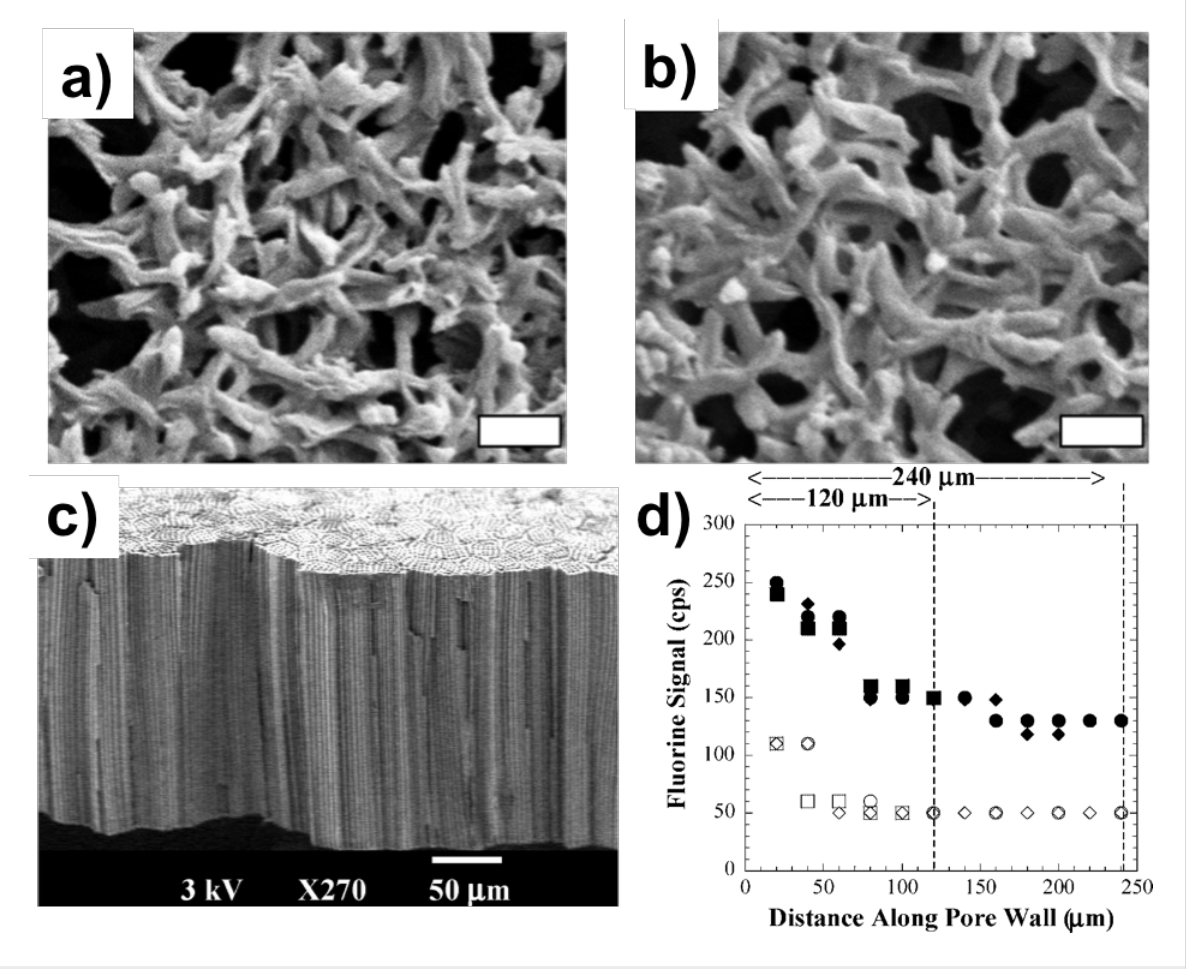
Figure 7: SEM of Nylon membranes a) uncoated and b) coated with 10 nm of iCVD pDVB (scale bar 1 µm). c) Cross-sectional SEM of capillary pore membrane. d) EMPA fluorine signal down 3 µm diameter pore with 2 minute deposition (unfilled) and 5 minute deposition (filled). Parts a) and b) reprinted with permission from [2], copyright 2016 Elsevier. Parts c) and d) reprinted with permission from [4], copyright 2008 American Chemical